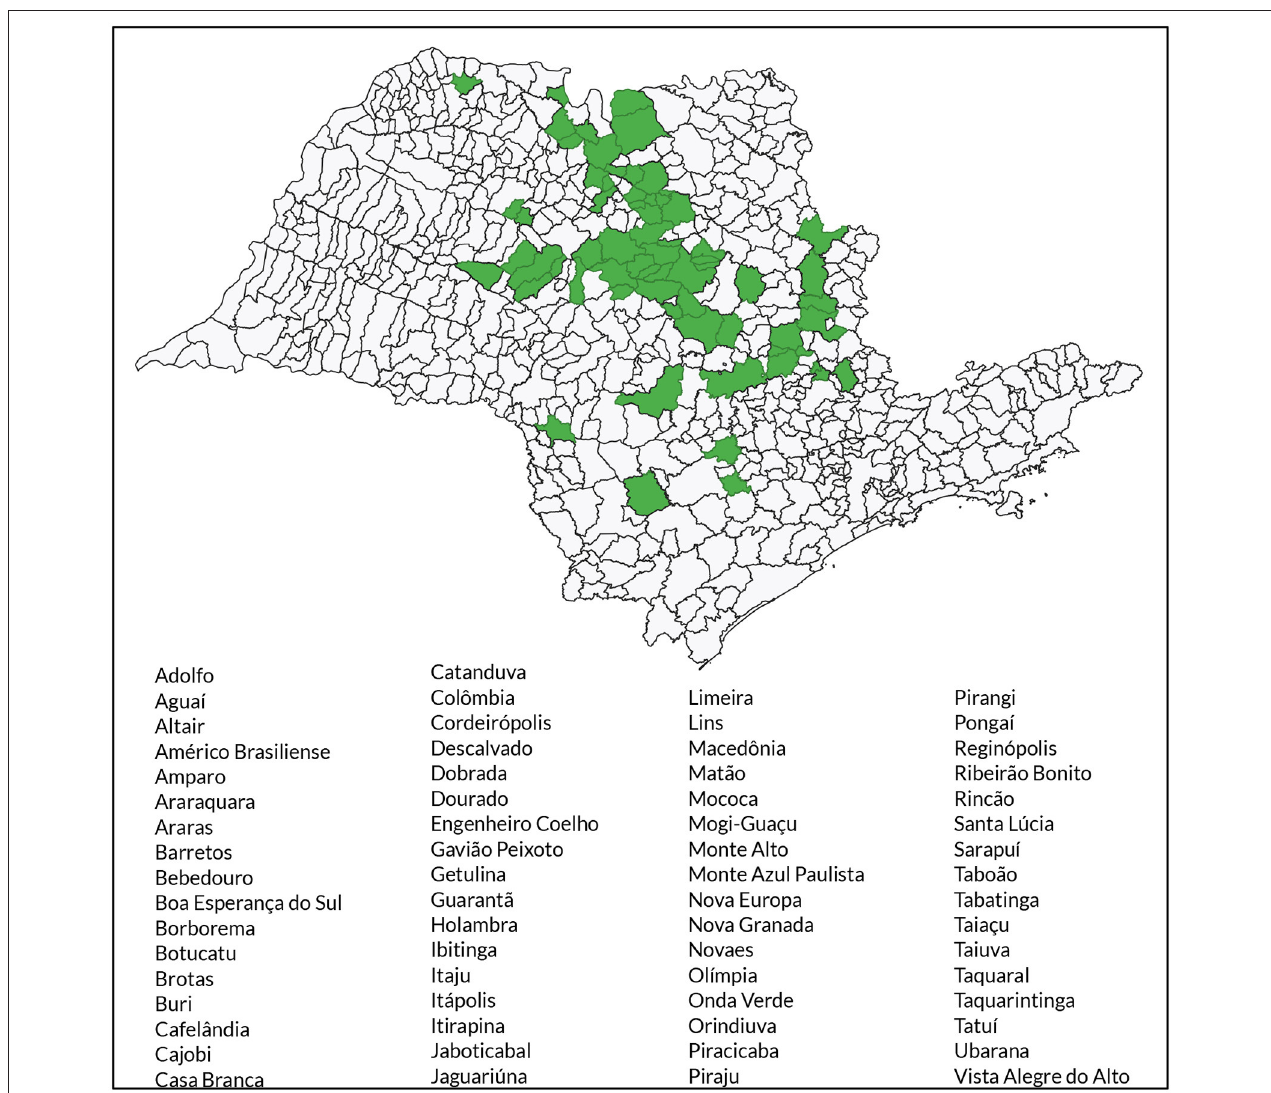
FIGURE 2 | Municipalities where Ageniaspis citricola was released for Phyllocnistis citrella control (Parra et al.,